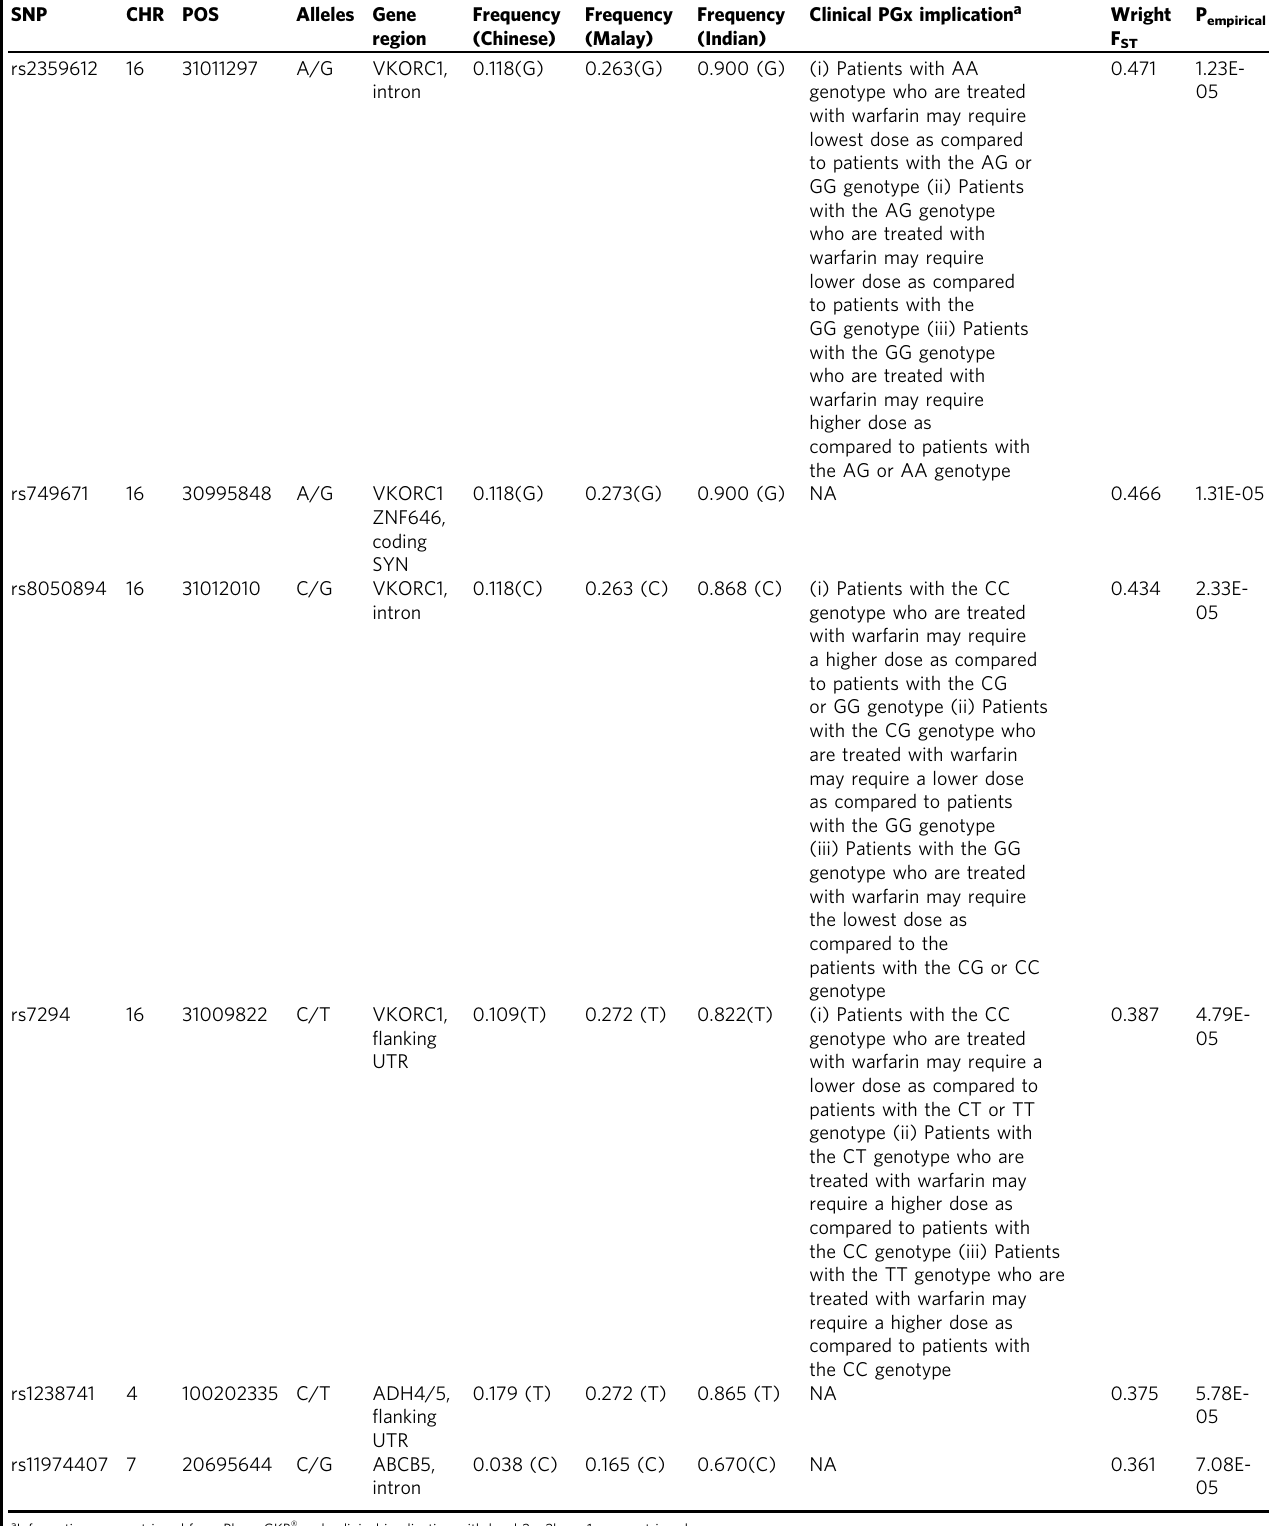
Table 2 Six candidate pharmacogenomic variants of most differentiated between three ethnic